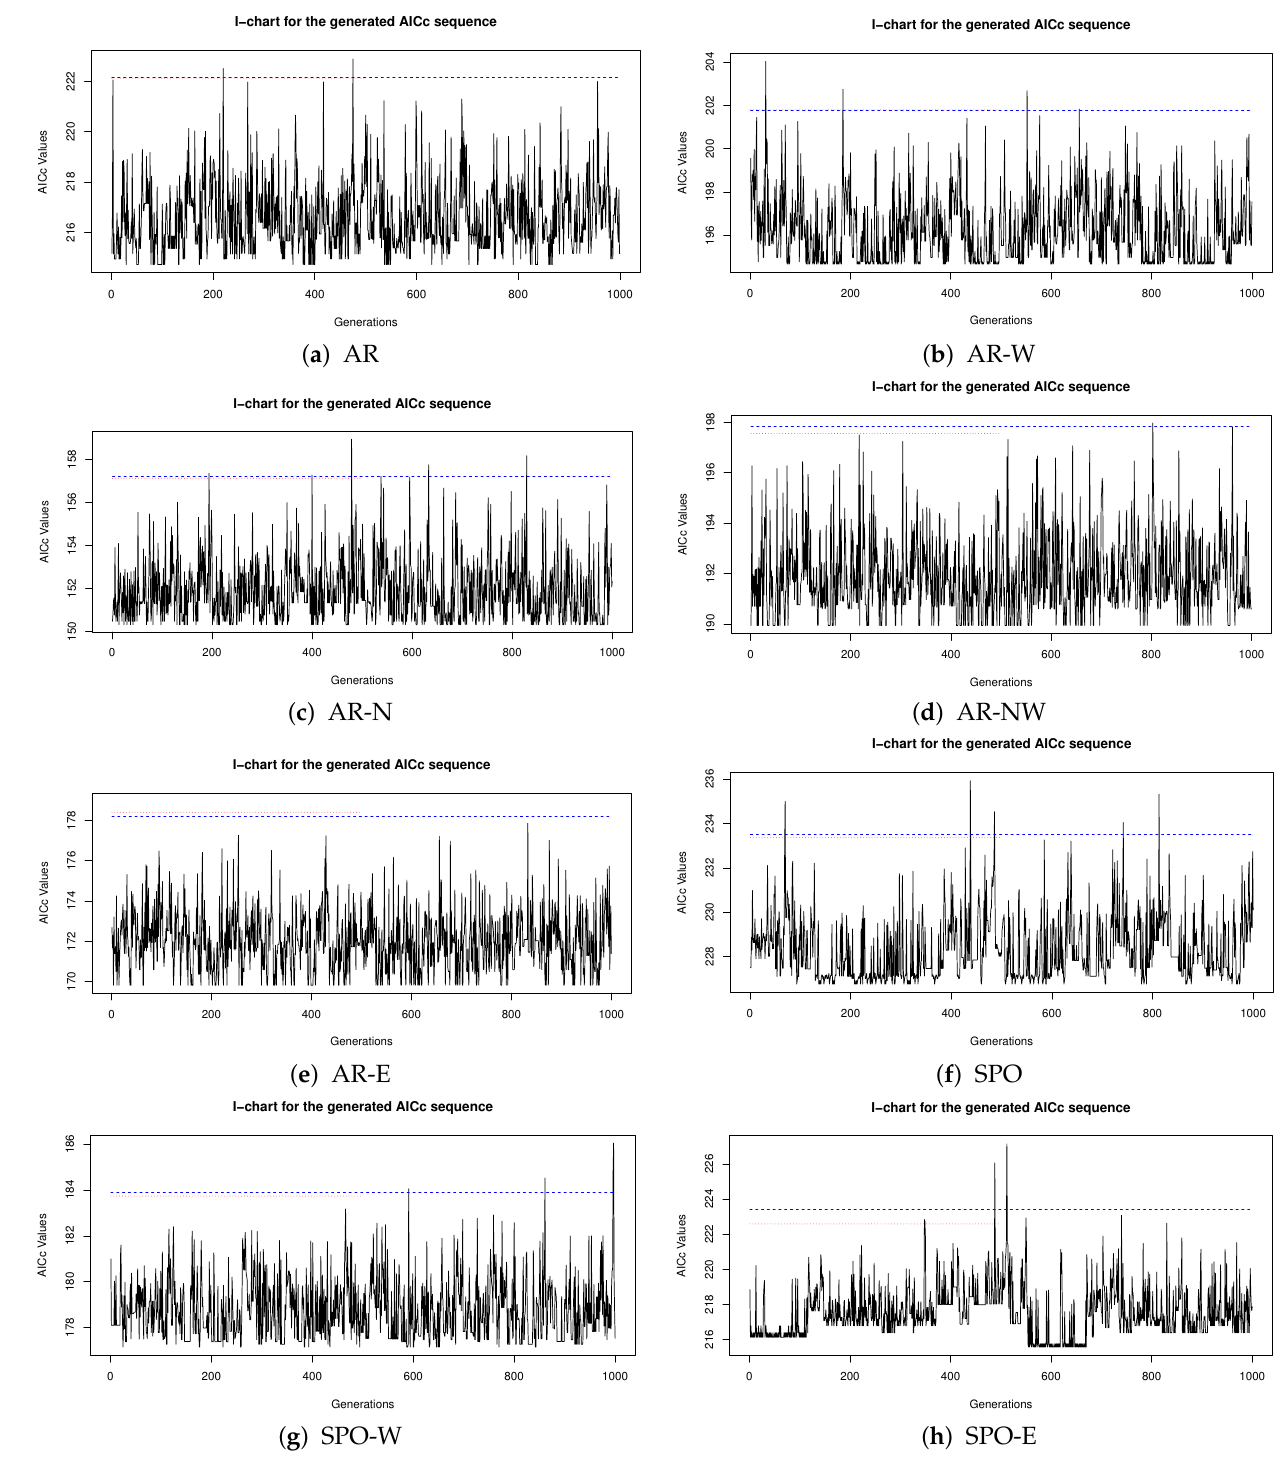
Figure 2. The I-chart for the generated AICc sequence in each region. The blue dashed line is the upper control limit for generations 1:1000, and the red dotted line is for generations